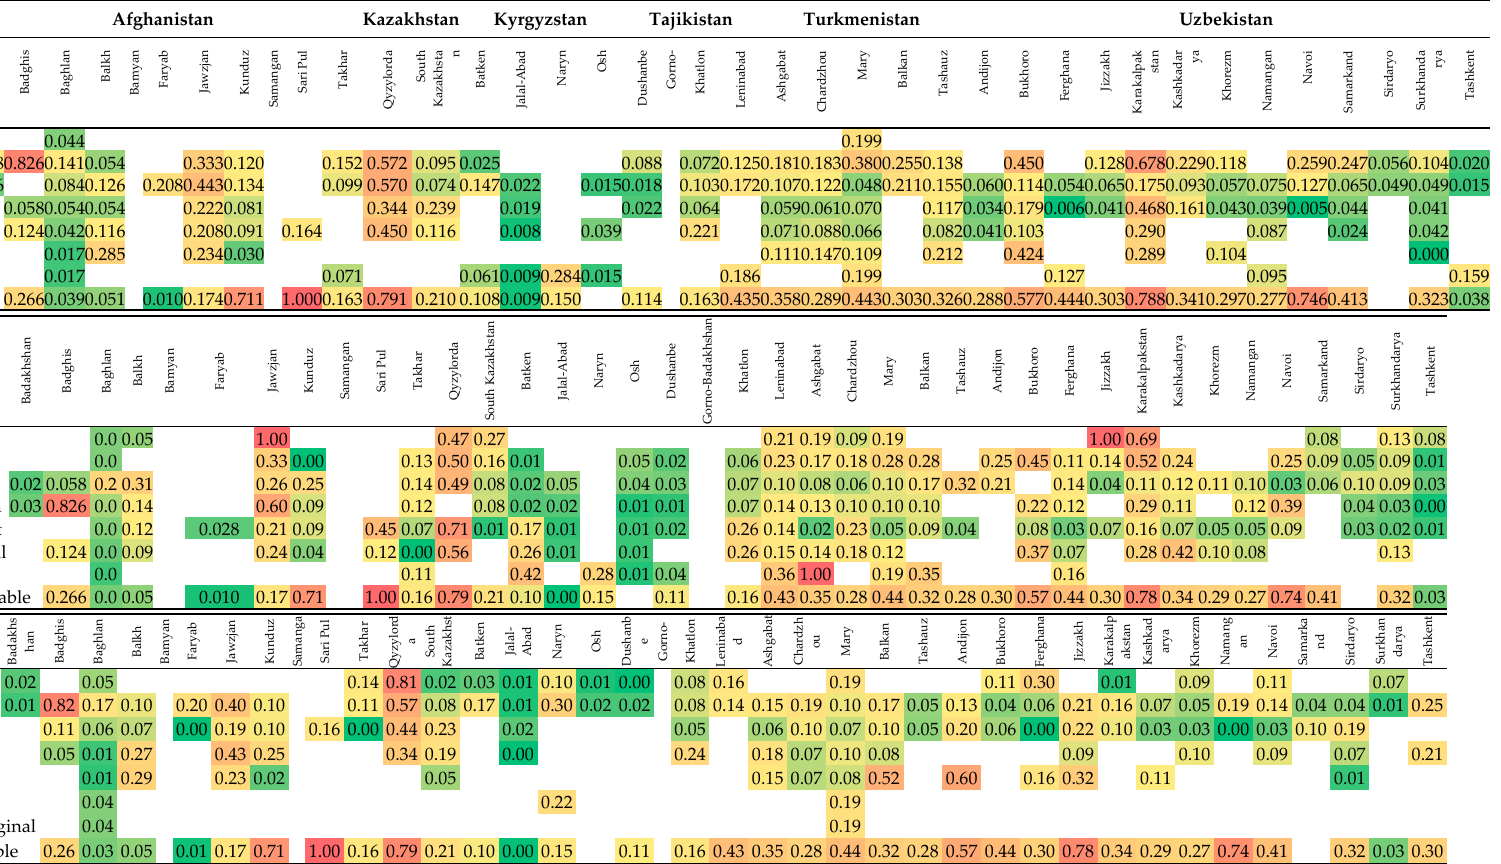
Table 6. Abandonment rates per crop suitability class in 39 administrative level-II regions (provinces) in six countries of the Aral Sea Basin while considering medium input level irrigated crop cultivation (cotton, rice and wheat). Abandonment data were based on map estimates from the stratified classifier and suitability indices (SI) based on GAEZ 3.0 (http://gaez.fao.org). Colors are added for the sake of readability: The dark red (green) color indicates highest (lowest) abandonment rates.